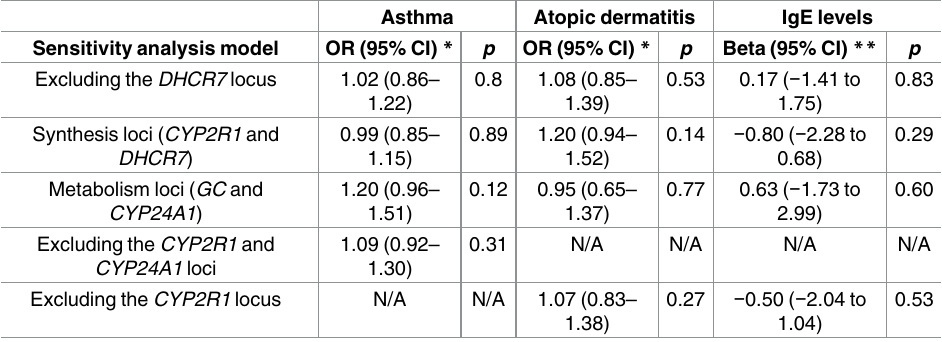
Table 3. Sensitivity analysestesting Mendelian Randomization (MR)